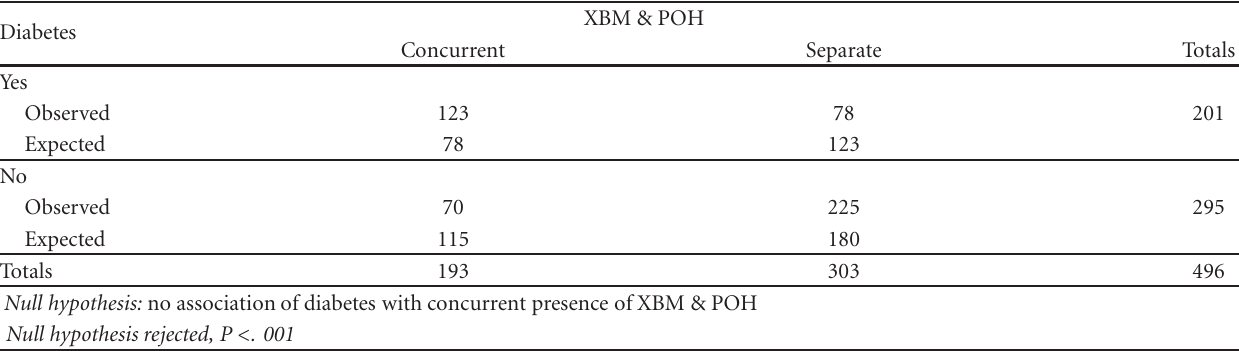
Table 4: The association of diabetes with concurrent XBM and POH compared to its association with the sum of XBM and POH occurring separately a .